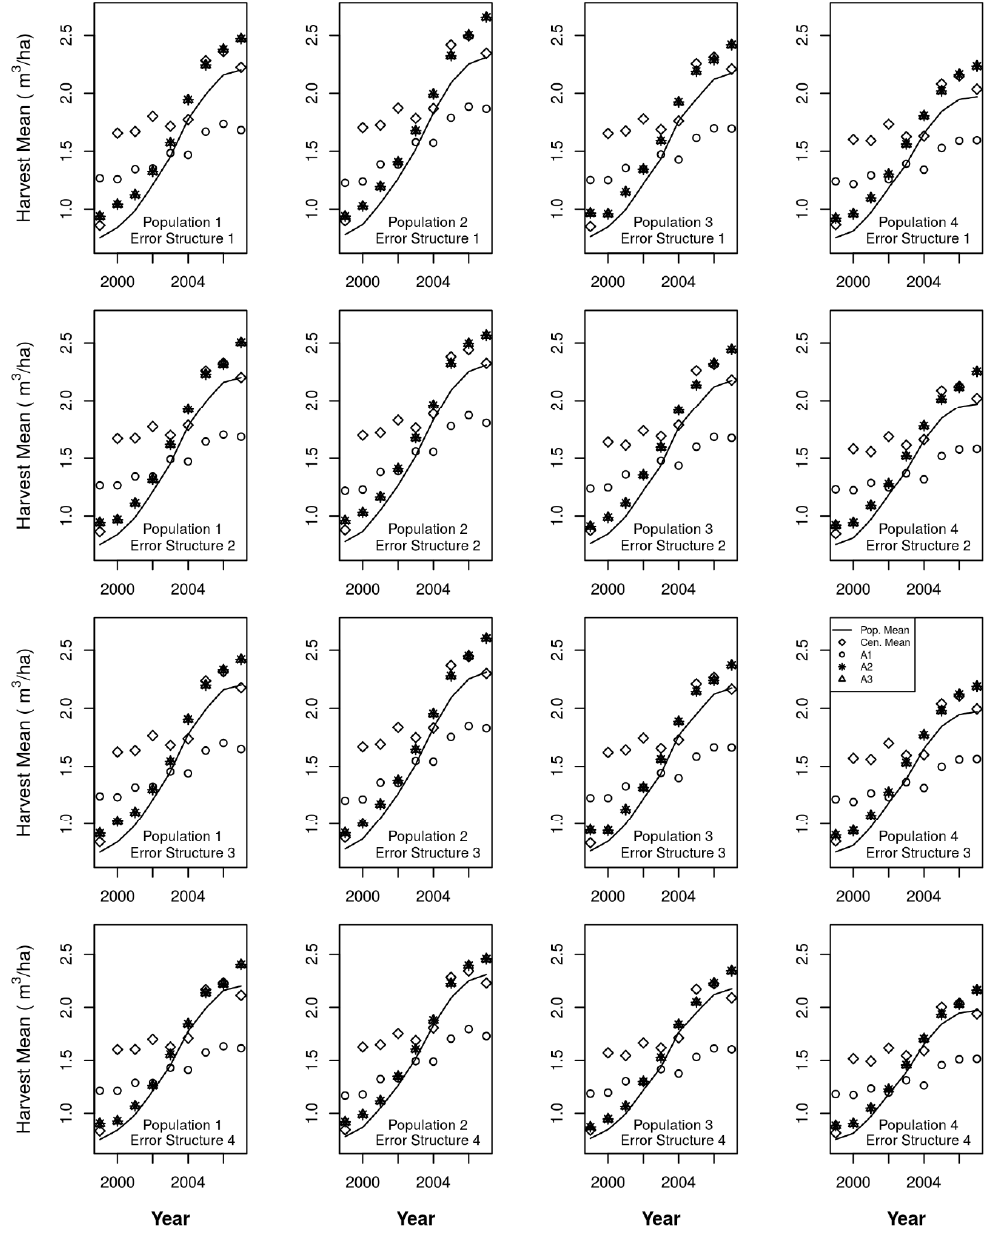
Figure 3. The means of the harvest estimators under A1, A2, and A3 and the centralized mean estimator relative to the population mean for harvest, over 1000 iterations of 1000 samples for each population and sample error